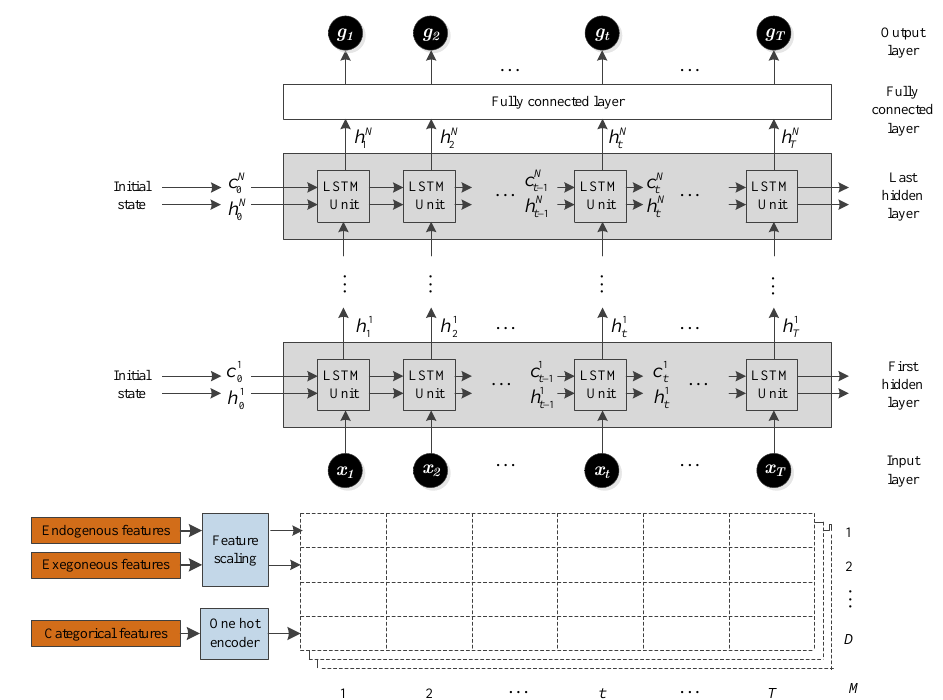
Figure 5. The proposed deep learning framework. In this figure, h denotes the output, c denotes the cell state, and N denotes the number of layers.